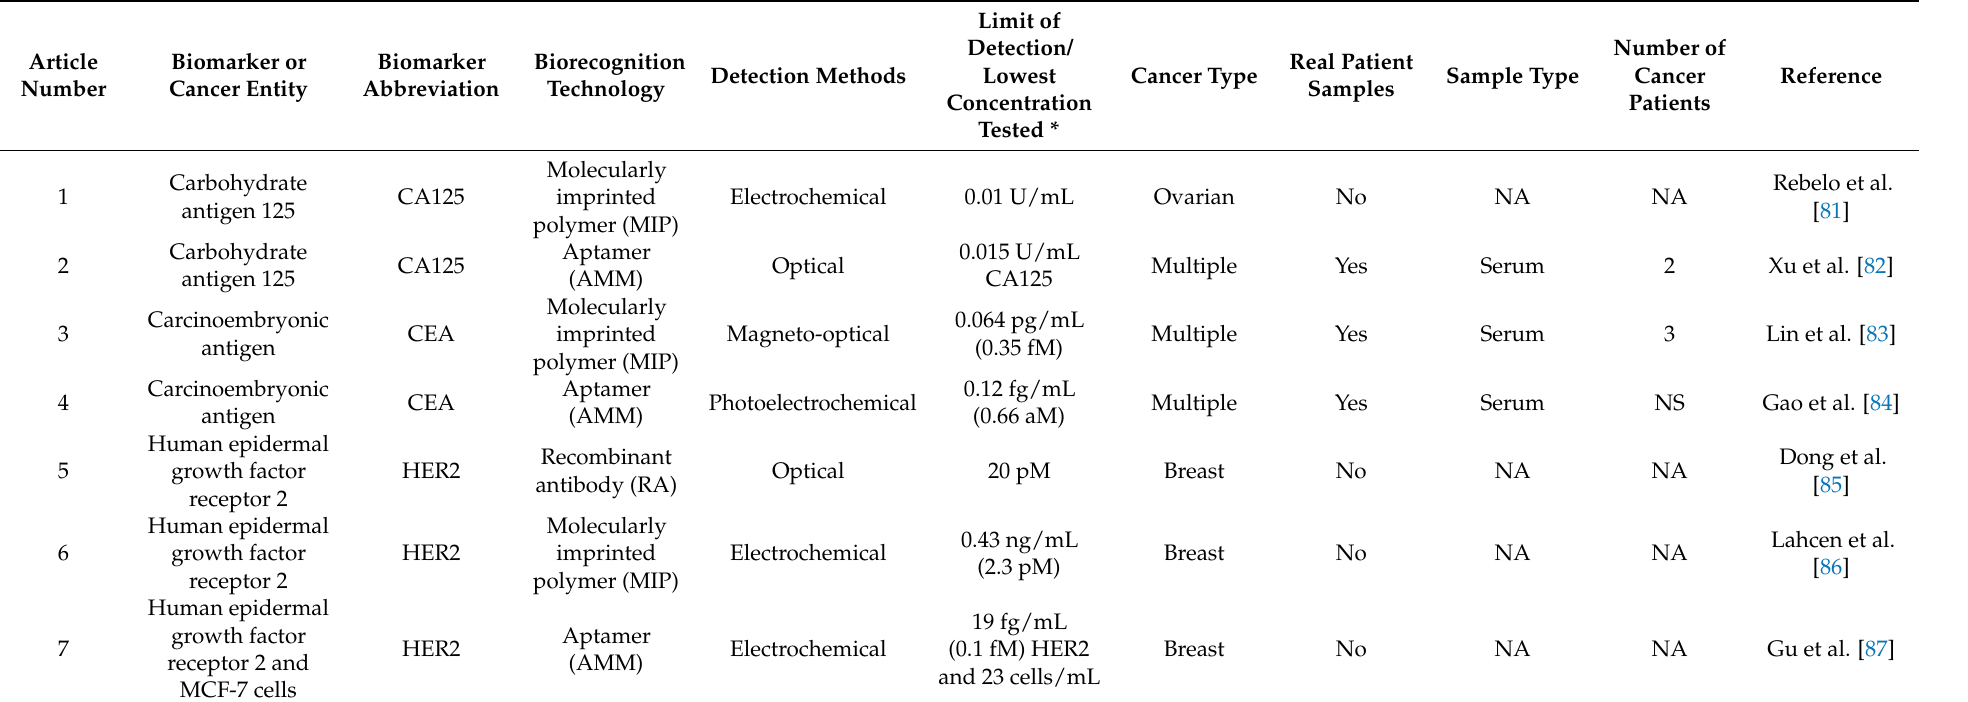
Table 7. Comparison of three biorecognition technologies using different cancer